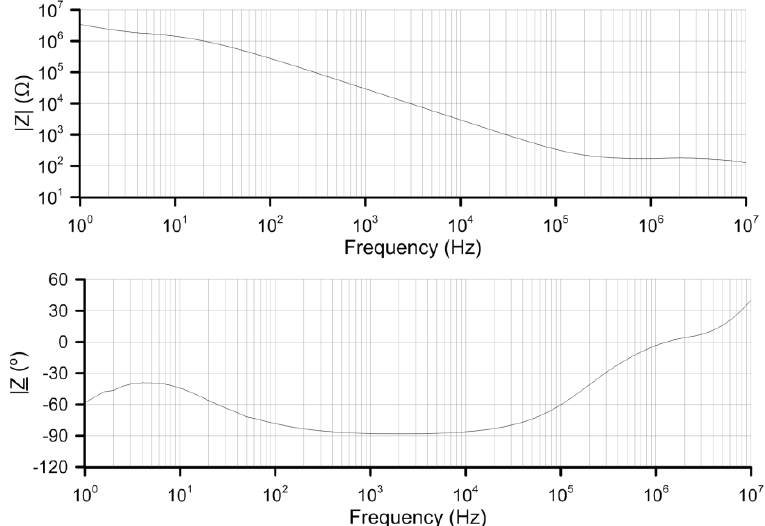
Figure 4. Frequency response of MDA 98-1602 nematic LC given as ( a ) impedance module and ( b )